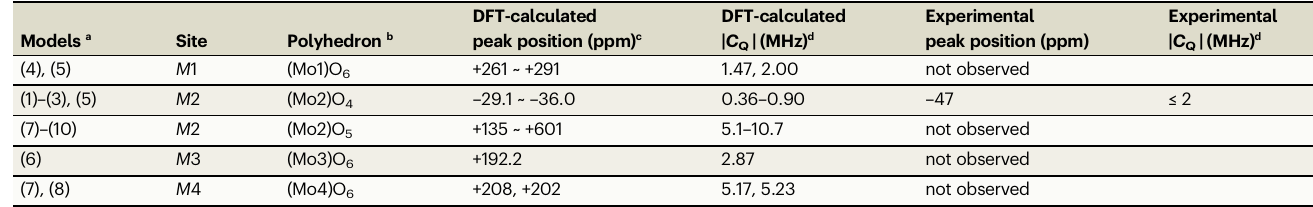
Table 1 | Calculated and experimental 95 Mo NMR parameters of Ba 7 Nb 4 MoO 20 , showing the peak assignment to the M 2